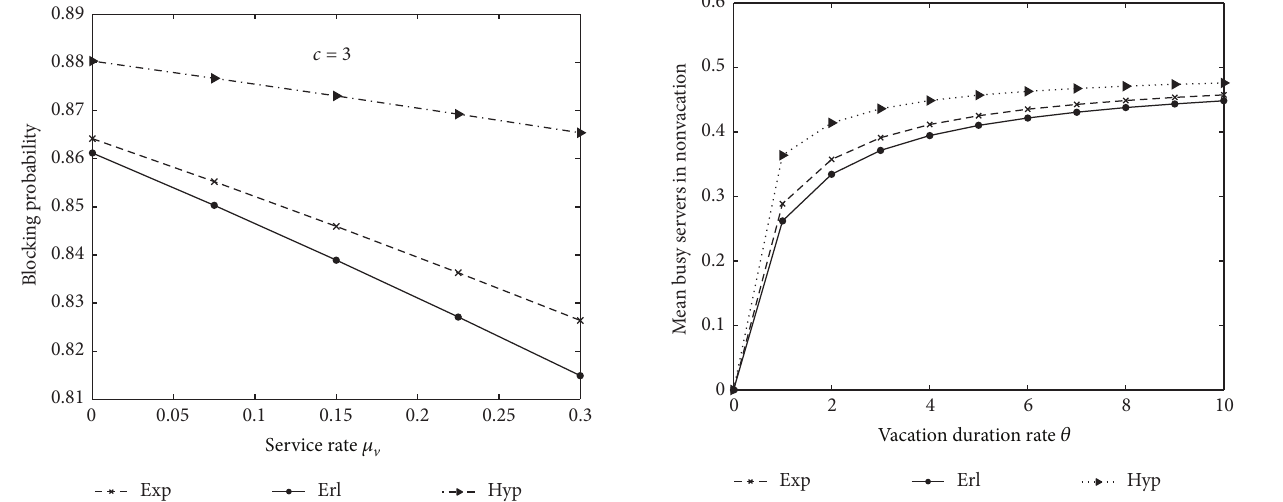
Figure 14: Blocking probability versus vacation-service rate with 𝜌 = 0.9 , 𝜃 = 1 , 𝜉 = 1 , and 𝑐 = 3 .